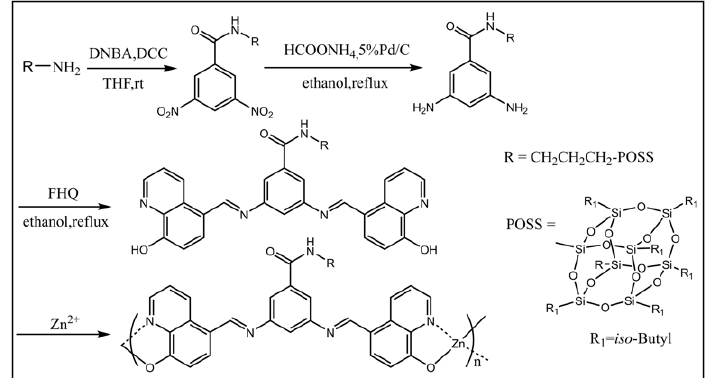
Molecules 2022 , 27 , x FOR PEER REVIEW Figure 4. Synthetic procedure of the ligands and polymers [73]. Figure 4. Synthetic procedure of the ligands and polymers [73].